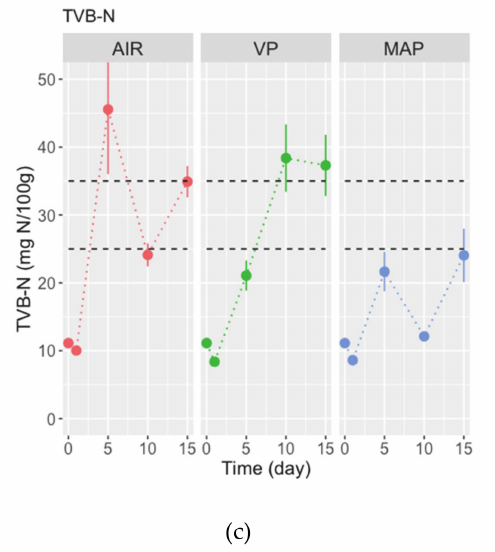
Figure 2. Changes in ( a ) pH, ( b ) hardness, and ( c ) TVB-N content in fillets of triggerfish packed in air (AIR), vacuum (VP), and modified atmosphere (MAP), and stored refrigerated for 15 days. Values are means of n = 2 fillets, and whiskers represent the standard-error (SE). Horizontal dashed lines in ( a ) represent the range of pH values referred for fresh fish [39], and in ( c ) represent the range of TVB-N values stipulated in EU Regulations